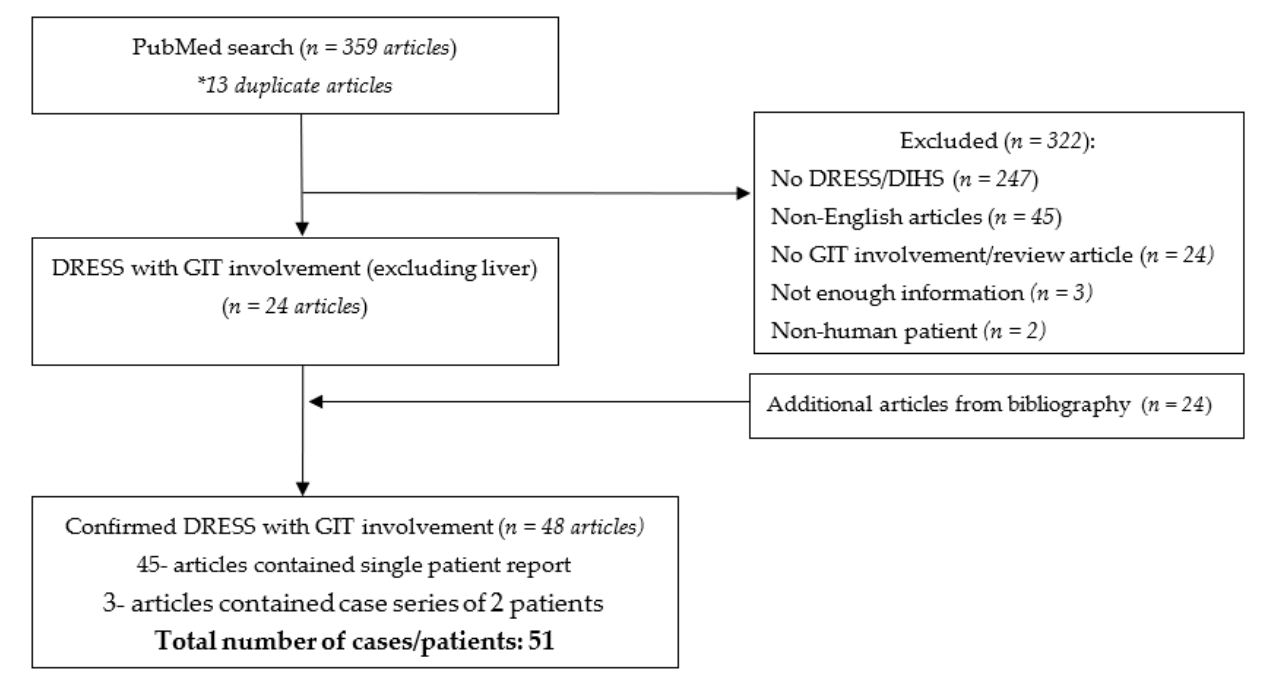
Scheme 1. PRISMA flow chart.